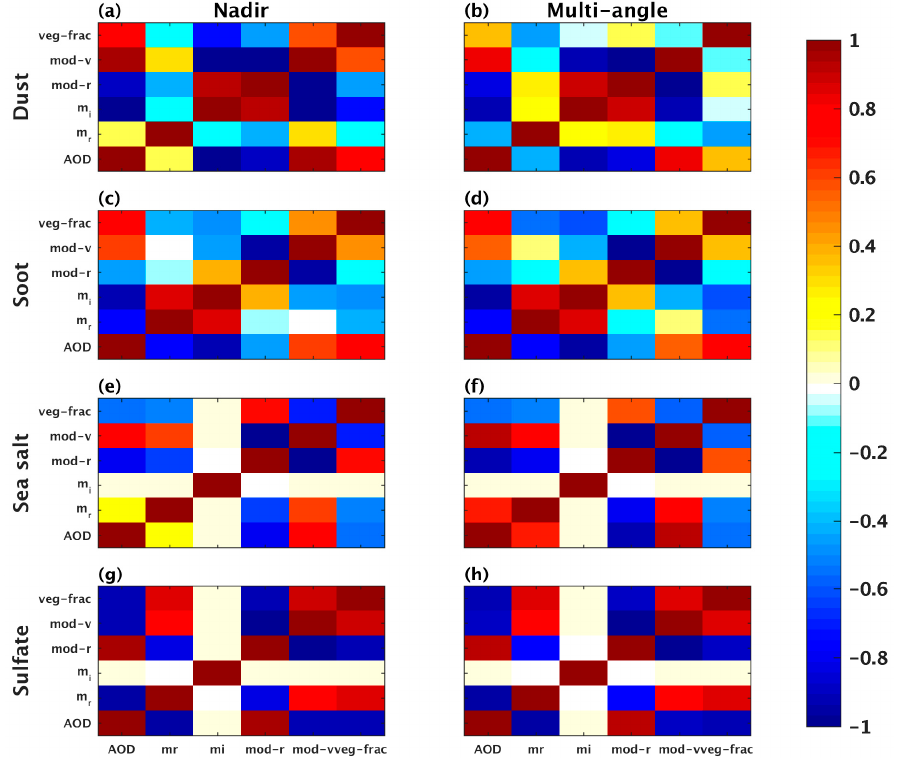
Figure 7. The correlation matrices of retrieval variables for four types of aerosols (four rows): dust ( a , b ), soot ( c , d ), sea salt ( e , f ) and sulfate ( g , h ). The left column is in nadir viewing mode, and the right column is in multi-angle mode.